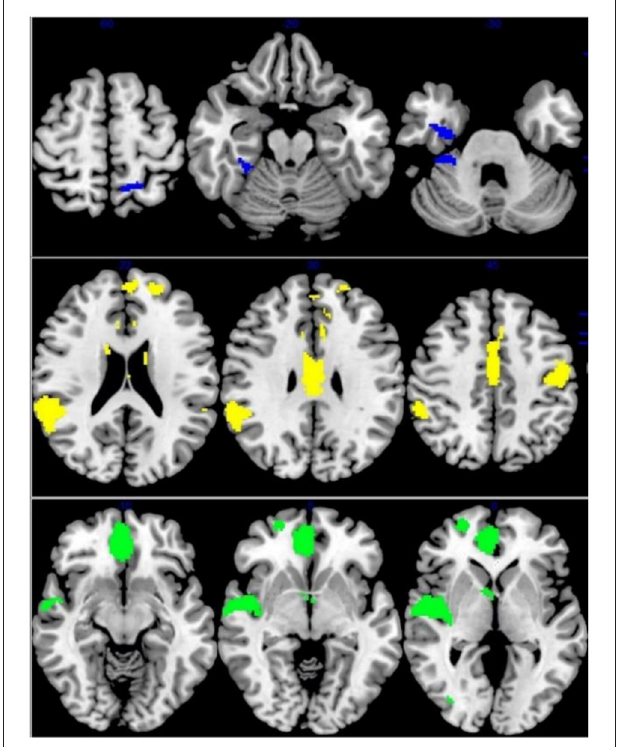
FIGURE 5 | Multimodel analysis in the ADHD. Blue: increased GMV and increased activation; Yellow: decreased GMV and functional connection; Green: decreased GMV and increased